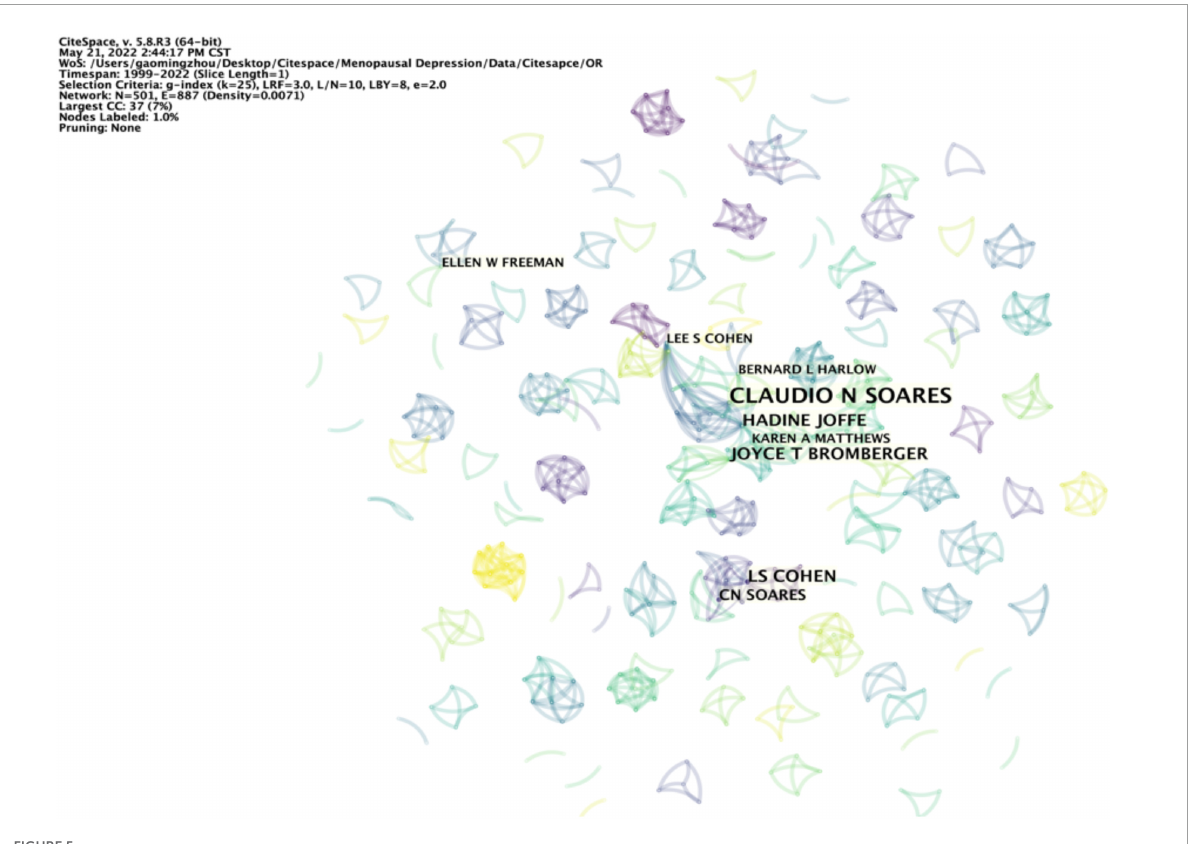
FIGURE5 Visualization map of authors of publications about PMD.